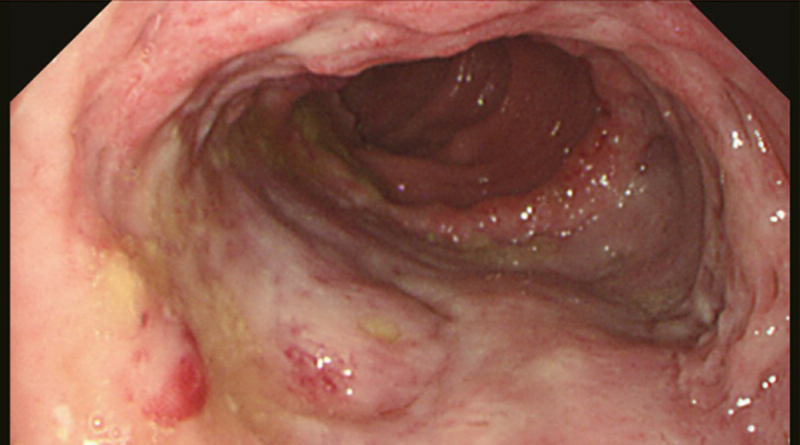
Colonoscopy showed the mucosa was obviously hyperemia and edema, showing cobblestone pattern change, with scattered erosion and ulcer.